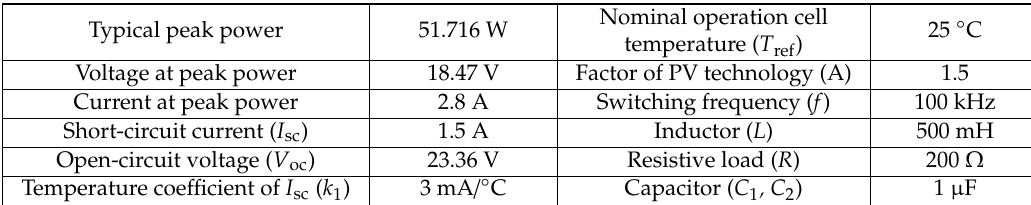
Table 2. The photovoltaic (PV) system parameters.